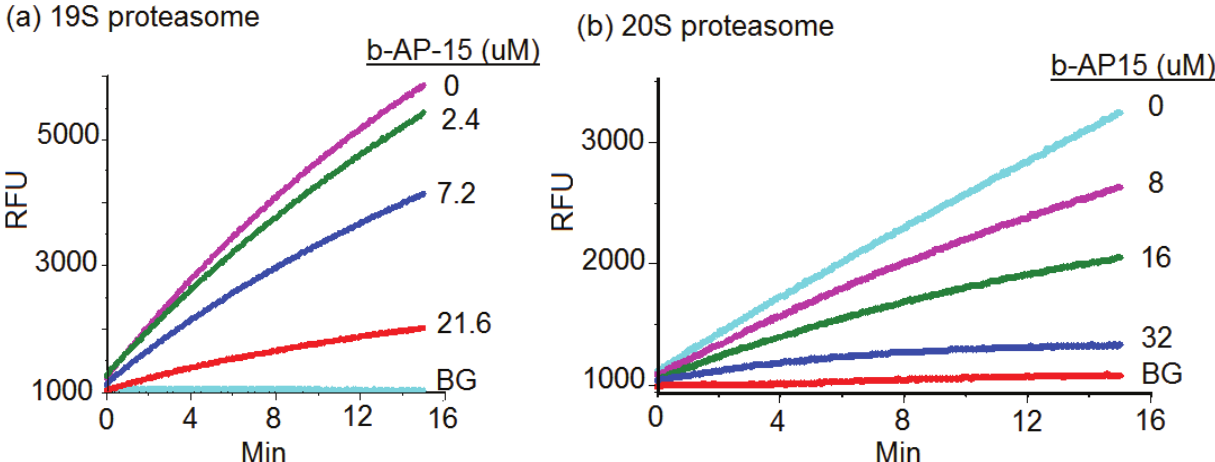
( b ) Inhibitory effect of b-AP15 on the chymotrypsin-like activity of the 20S proteasome. BG in the figure denotes